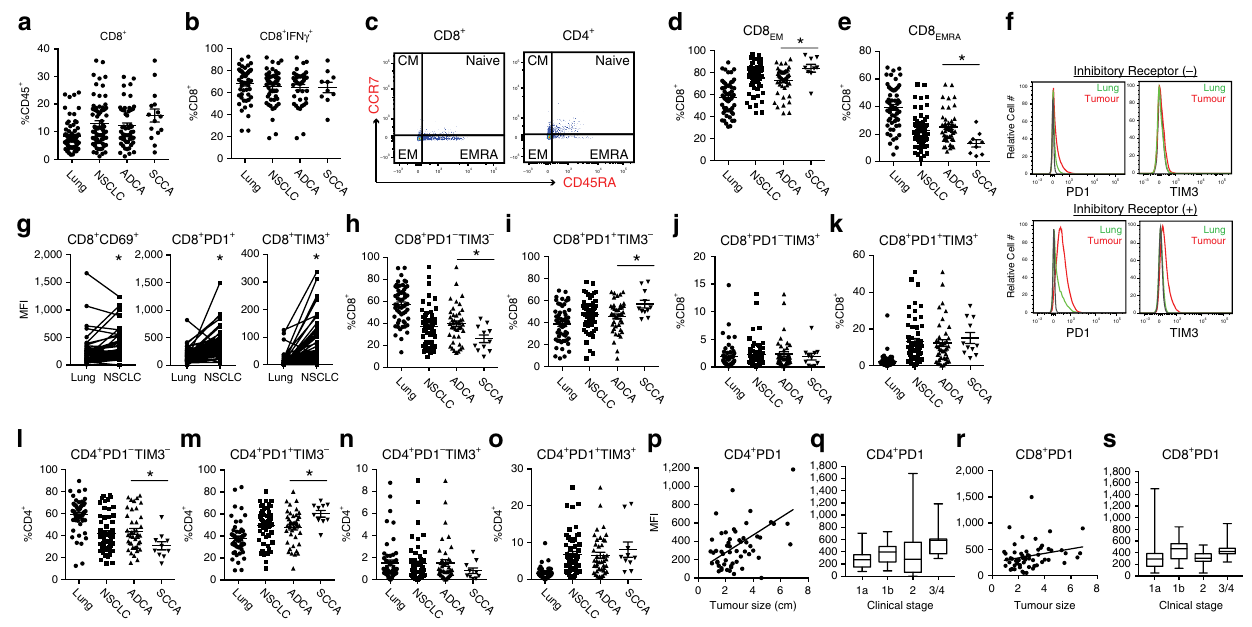
Figure 4 | CD4 þ and CD8 þ function segregate by NSCLC subtype. ( a ) CD8 þ cells shown as % CD45 þ and ( b ) CD8 þ IFN g þ shown as per cent of CD8 þ . ( c ) Representative dot plots showing CD8 þ and CD4 þ cell subtypes (CCR7 (cid:3) CD45RA (cid:3) effector memory, CCR7 (cid:3) CD45RA þ effector memory RA, CCR7 þ CD45RA (cid:3) central memory, CCR7 þ CD45RA þ naı¨ve). Statistical analyses of ( d ) CD8 þ EM (L-ADCA versus L-SCCA, * P ¼ 0.0123, N ¼ 54) and ( e ) CD8 þ EMRA (L-ADCA versus L-SCCA, * P ¼ 0.0064, N ¼ 54). ( f ) Representative histograms of low (top) and high expression of inhibitory receptors (bottom) on CD8 þ cells determined by expression (MFI) of PD1 (left) and TIM3 (right). Matched normal lung-tumour pairs for ( g ) CD8 þ CD69 þ (left, * P ¼ 0.0003, N ¼ 55). CD8 þ PD1 þ (middle, * P o 0.0001, N ¼ 56) and CD8 þ TIM3 þ (right, * P o 0.0001, N ¼ 56) content. ( h ) CD8 þ PD1 (cid:3) TIM3 (cid:3) (* P ¼ 0.0156, N ¼ 53), ( i ) CD8 þ PD1 þ TIM3 (cid:3) (* P ¼ 0.0188, N ¼ 53), ( j ) CD8 þ PD1 (cid:3) TIM3 þ , ( k ) CD8 þ PD1 þ TIM3 þ ( l ) CD4 þ PD1 (cid:3) TIM3 (cid:3) (* P ¼ 0.027, N ¼ 51), ( m ) CD4 þ PD1 þ TIM3 (cid:3) (* P ¼ 0.0195, N ¼ 51), ( n ) CD4 þ PD1 (cid:3) TIM3 þ and ( o ) CD4 þ PD1 þ TIM3 þ flow cytometry data displayed as %CD8 or %CD4 for L-ADCA and L-SCCA. Associations of CD4 þ PD1 and ( p ) tumor size (linear correlation, P ¼ 0.0001, R 2 ¼ 0.2386, N ¼ 43), ( q ) clinical stage (ANOVA, stage 1a versus 3/4, P ¼ 0.0277, N ¼ 43) and associations of CD8 þ PD1 and ( r ) tumour size (linear correlation, P ¼ 0.0598, R 2 ¼ 0.0629, N ¼ 43) and ( s ) clinical stage (ANOVA, stage 1a versus 3/4, P ¼ 0.1798, N ¼ 43). Student’s tests were performed to compare two groups (all except, c , f , p – s ), Pearson correlation calculations were performed for linear correlations ( p , r ) and one-way ANOVA analysis was performed for multiple comparisons ( q , s ). Each dot represents an independent data point as determined by flow cytometry. Data are presented as mean ± s.e.m. * P o 0.05. ANOVA, analysis of